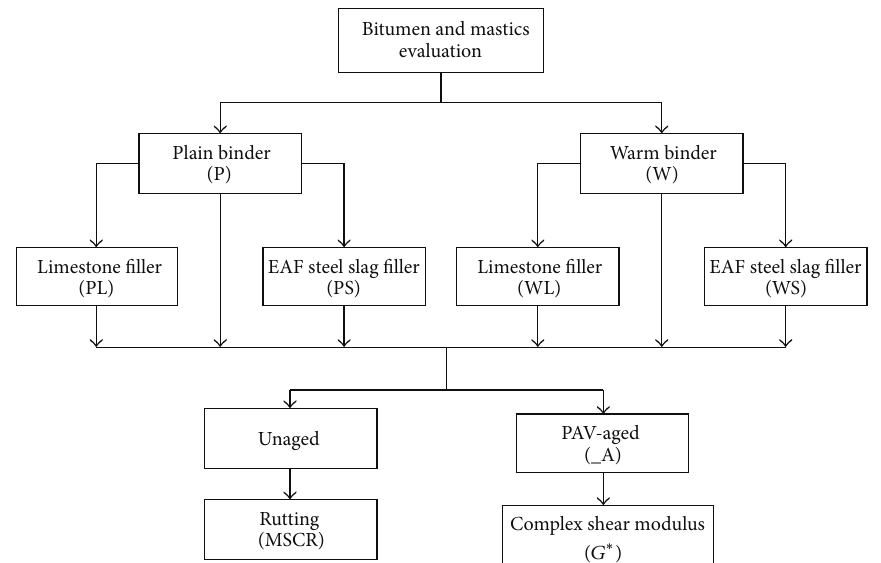
Figure 2: Experimental